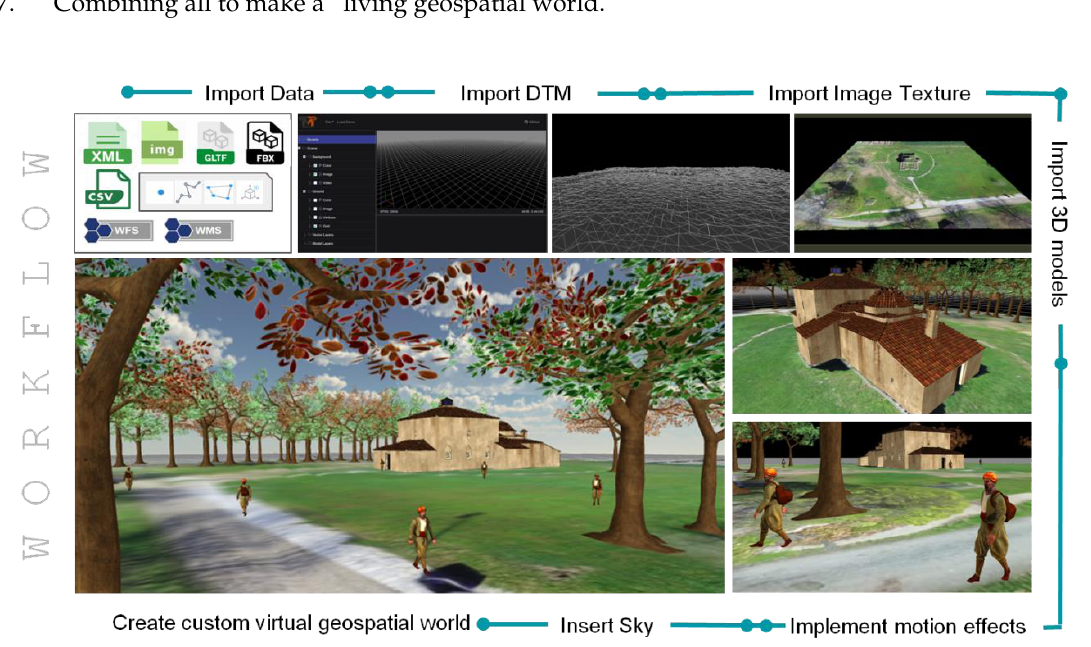
Figure 7. An overview of “Mergin’ Mode” authoring tool user interface.